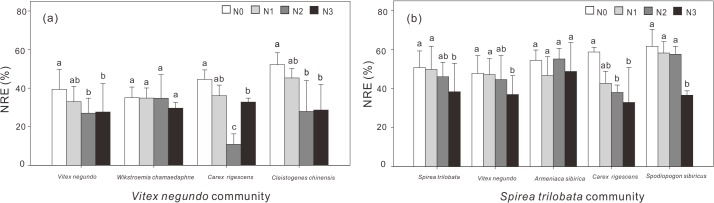
Responses of mean N resorption efficiency (NRE) to N addition for seven dominant species in the Vitex negundo (a) and Spirea trilobata (b) communities.Error bars indicate standard deviation (n = 6). Different letters on the error bars indicate significant differences among treatments for each species based on one-way ANOVA.